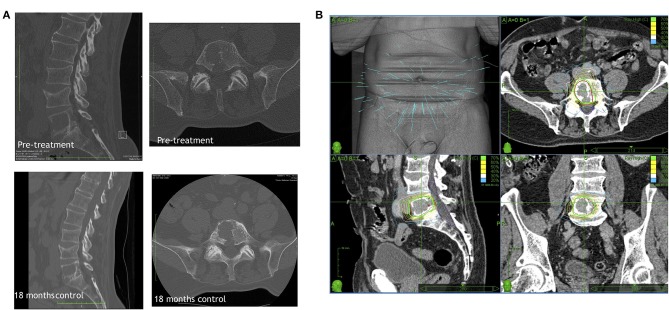
A representative primary Cyberknife treatment case showing (A) the CT scan of the lesion before and 18 months after the treatment visualizing the stable lesion and (B) the Cyberknife therapy planning.